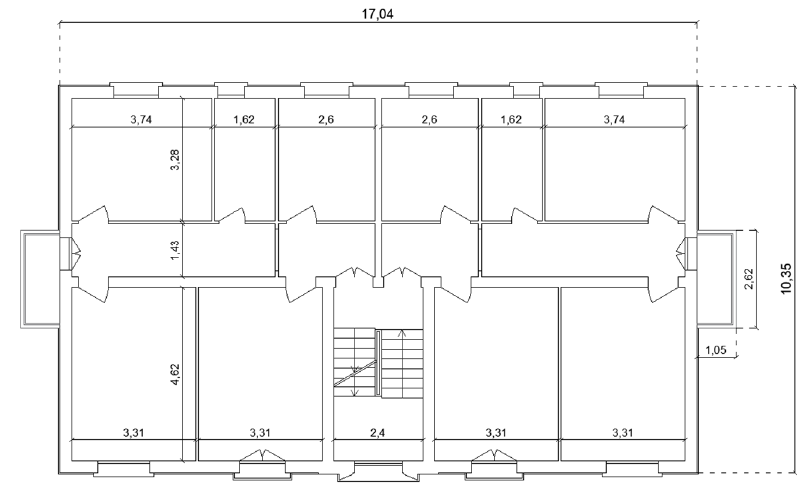
Figure 5. Standard plan layout of the building under study. (unit: m) While the external load-bearing masonry structure is made of solid bricks and mor- tar, giving rise to walls with a thickness of about 30 cm, the intermediate horizontal floors are realized with SAP-type slabs of different thicknesses at various levels (14 cm in the basement and 16 cm at other floors). The SAP floor, typical of the ‘50s, is a semi-prefabri- cated slab consisting of prefabricated bricks and reinforced concrete joists. The reinforce- ment bars, of smooth type and with reduced diameter, are placed inside special grooves of the bricks and sealed with mortar [19]. The roof structure is made of timber beams covered by a layer of tiles. Figure 6 shows an external view of the building obtained from Google Maps–Street View.